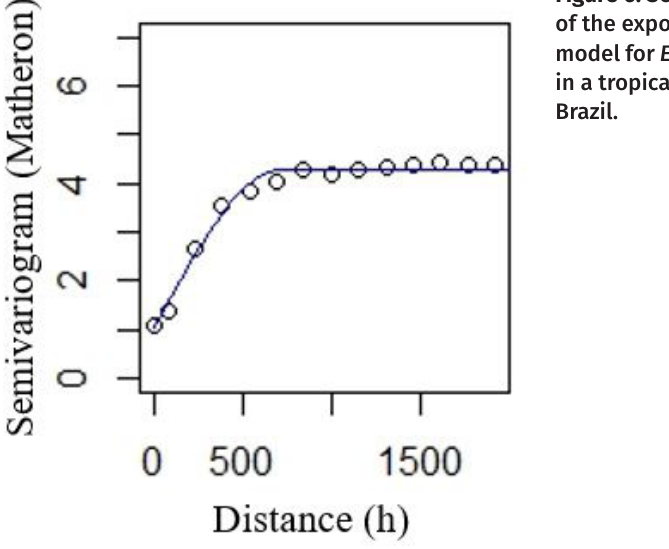
Figure 6. Semivariogram of the exponential model for Eucalyptus sp. in a tropical region of Brazil.